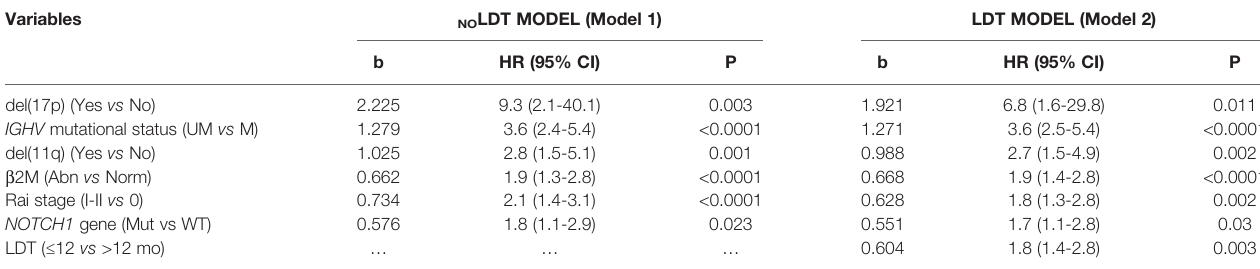
TABLE 2 | Regression coef fi cients (b) derivedfromtwo multivariatemodelswhere lymphocyte doubling time (LDT) whereexcluded ( NO LDTMODEL) or included (LDTMODEL). Variables